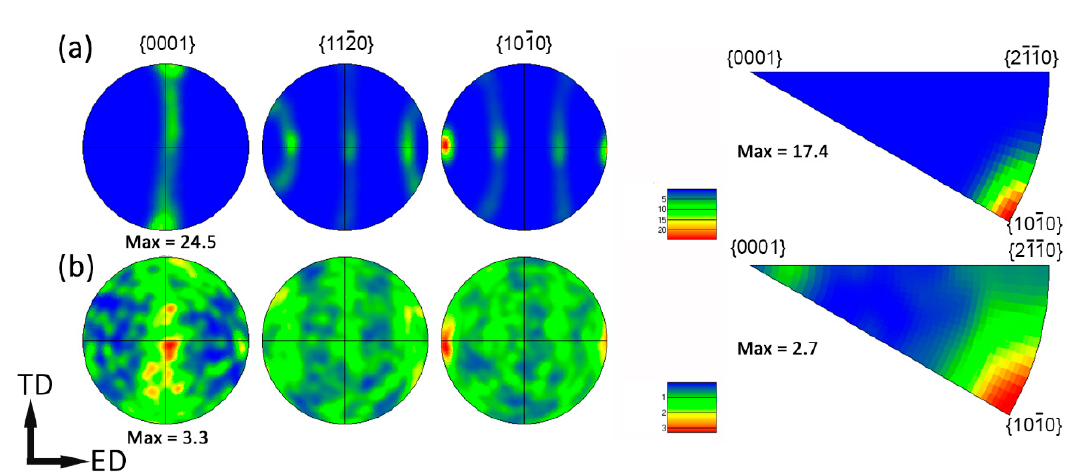
Figure 9. Pole figures and inverse pole figures of the ZX10 alloy extruded at 300 °C. ( a ) unDRXed regions and ( b ) DRXed regions.